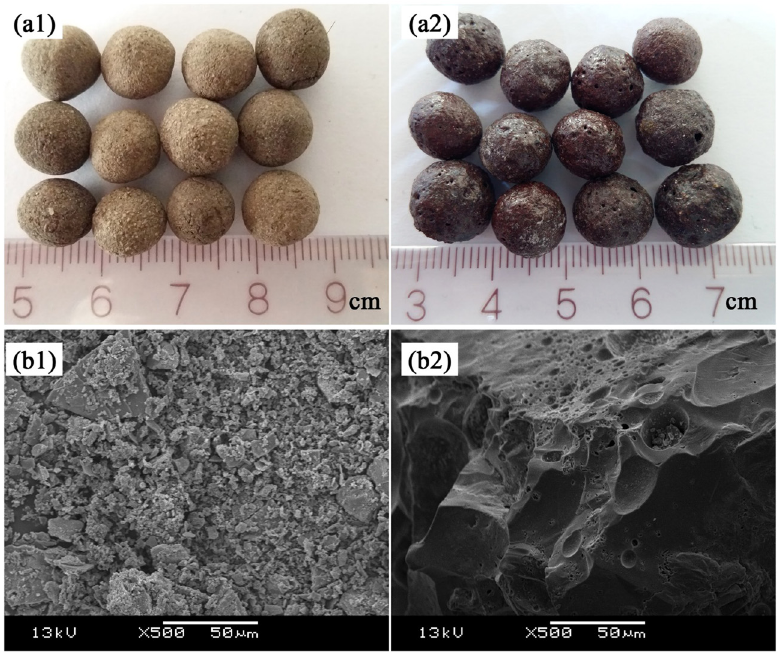
Figure 2: Pictures ( a1: green bodies, a2: porous ceramsites ) and SEM images ( b1: green bodies, b2: porous ceramsites ) of